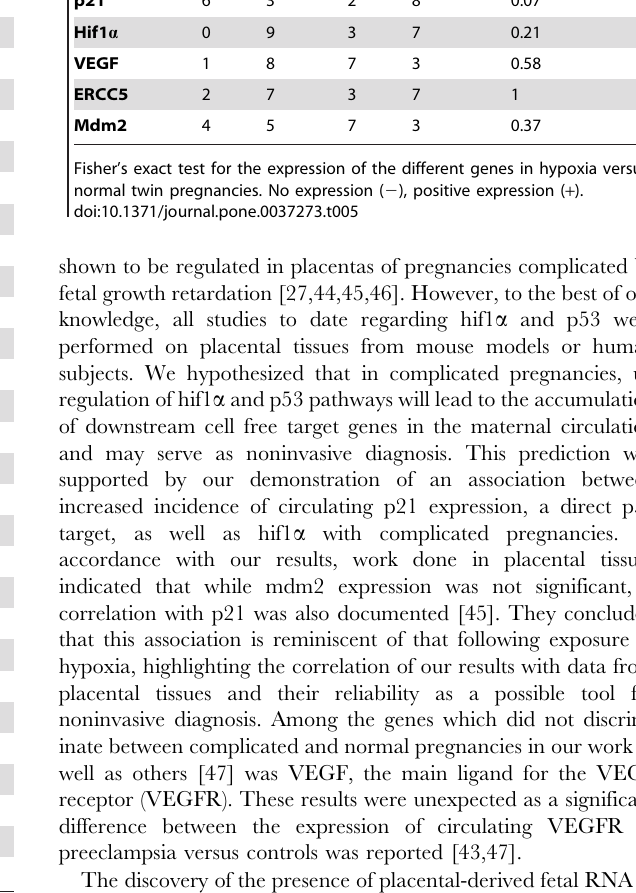
Table S1 Characteristics of the study cohort: H, Hypoxia; N, Normal; NA, Not available; G, Number of pregnancies; P,